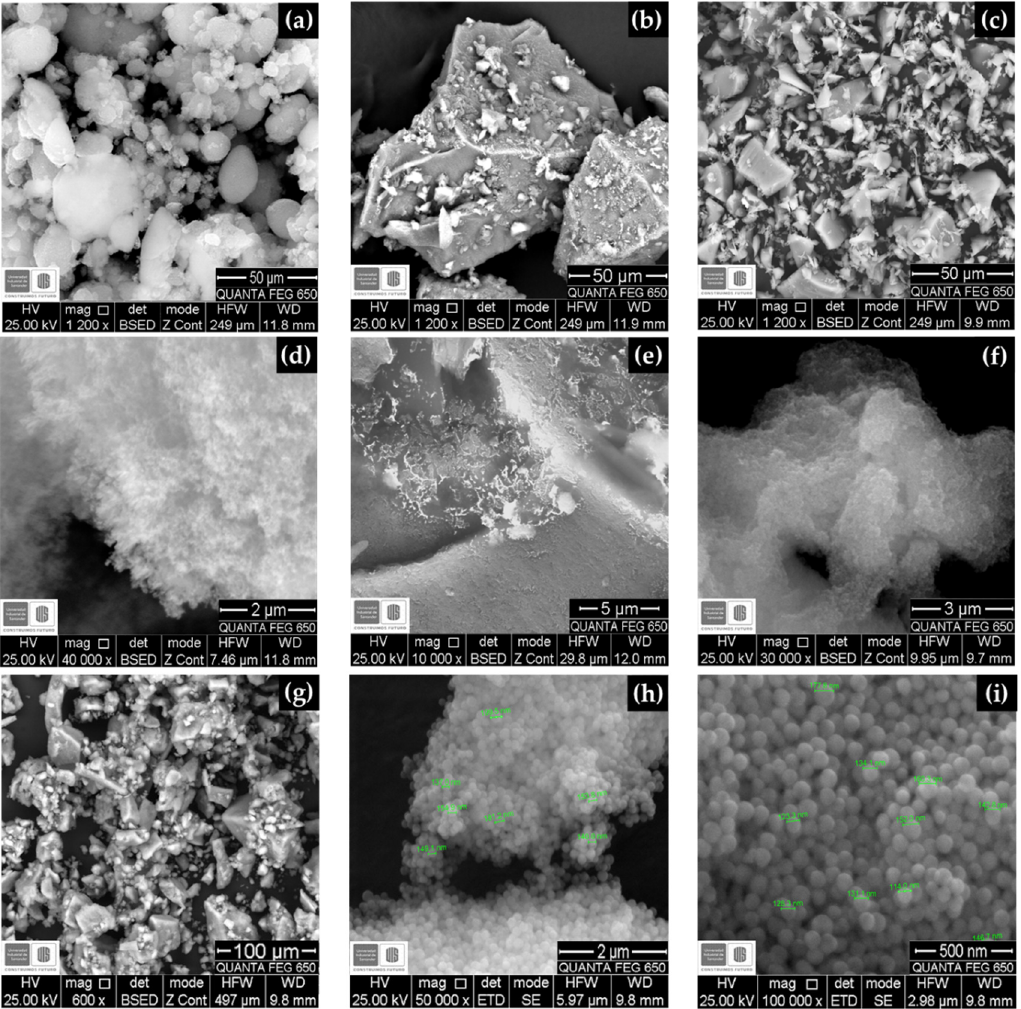
Figure 4. SEM micrographs of ( a , d ) A200 NPs at 1200× and 40,000×, respectively; ( b , e ) A200A NPs at 1200× and 10,000×, ( c , f ) A200S NPs at 1200× and 30,000× and ( g – i ) nSiO 2 -APTES NPs at 600×, 50,000× and 100,000×, respectively.